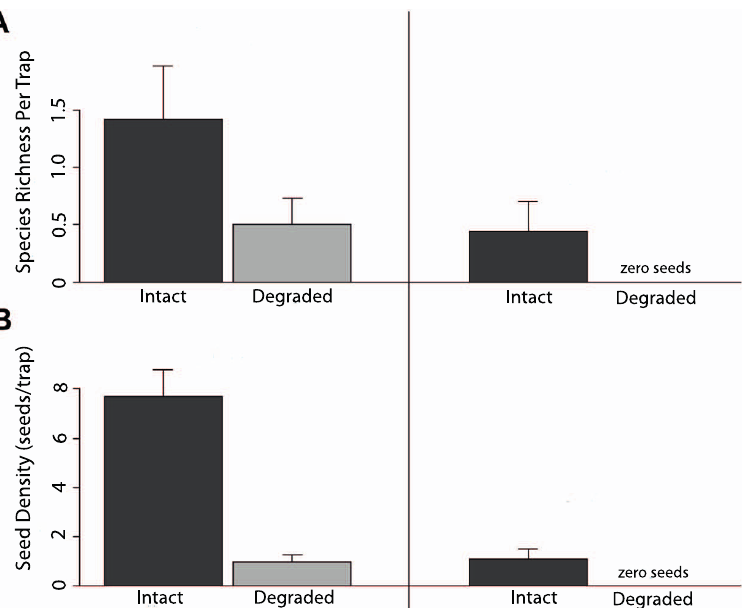
Figure 2. Mean (A) species richness and (B) density of native bird-dispersed seeds on Guam and Saipan. Dark grey bars indicate intact karst forest, while light grey bars indicate degraded forest. Error bars represent standard error. Means were calculated using raw data on native bird- dispersed seeds per trap (0.5 m 2 ); in degraded forests, we used only seeds found in traps with no remnant native trees nearby.